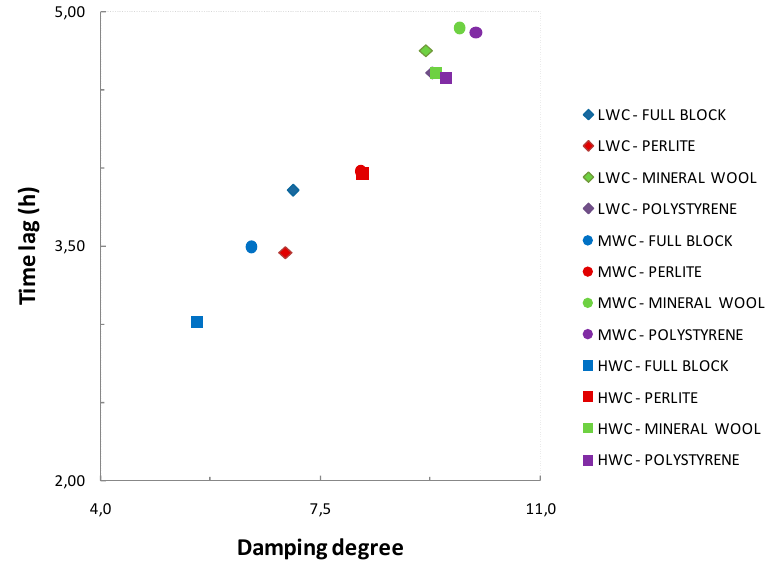
Figure 9. Time lag (in hours) vs. damping degree, all material combinations.